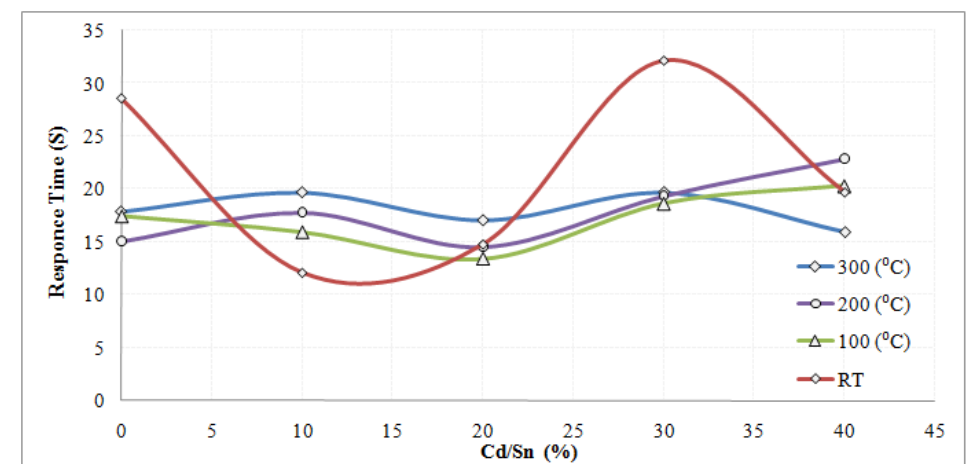
Fig. 6: The variation of response time as a function of time with different operating temperature of SnO : CdO thin films towards NO 2